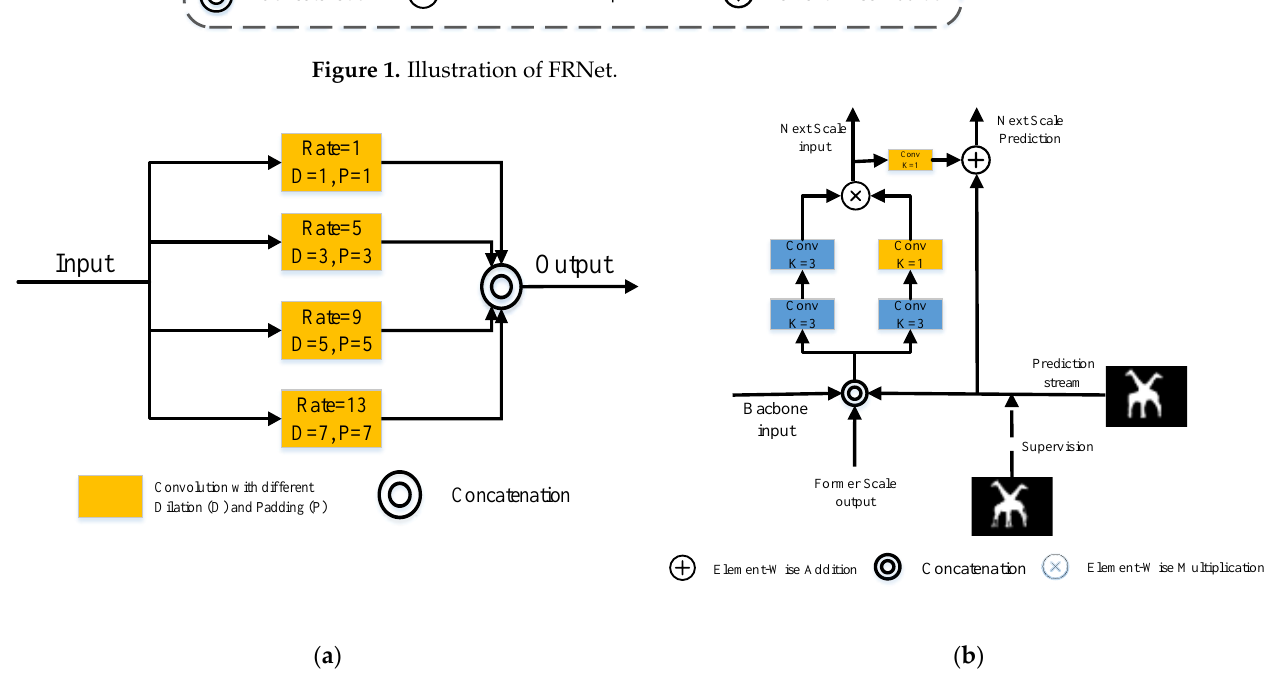
Figure 2. ( a ) Structure of DCPP [15] module; ( b ) details of ARM [15] module.